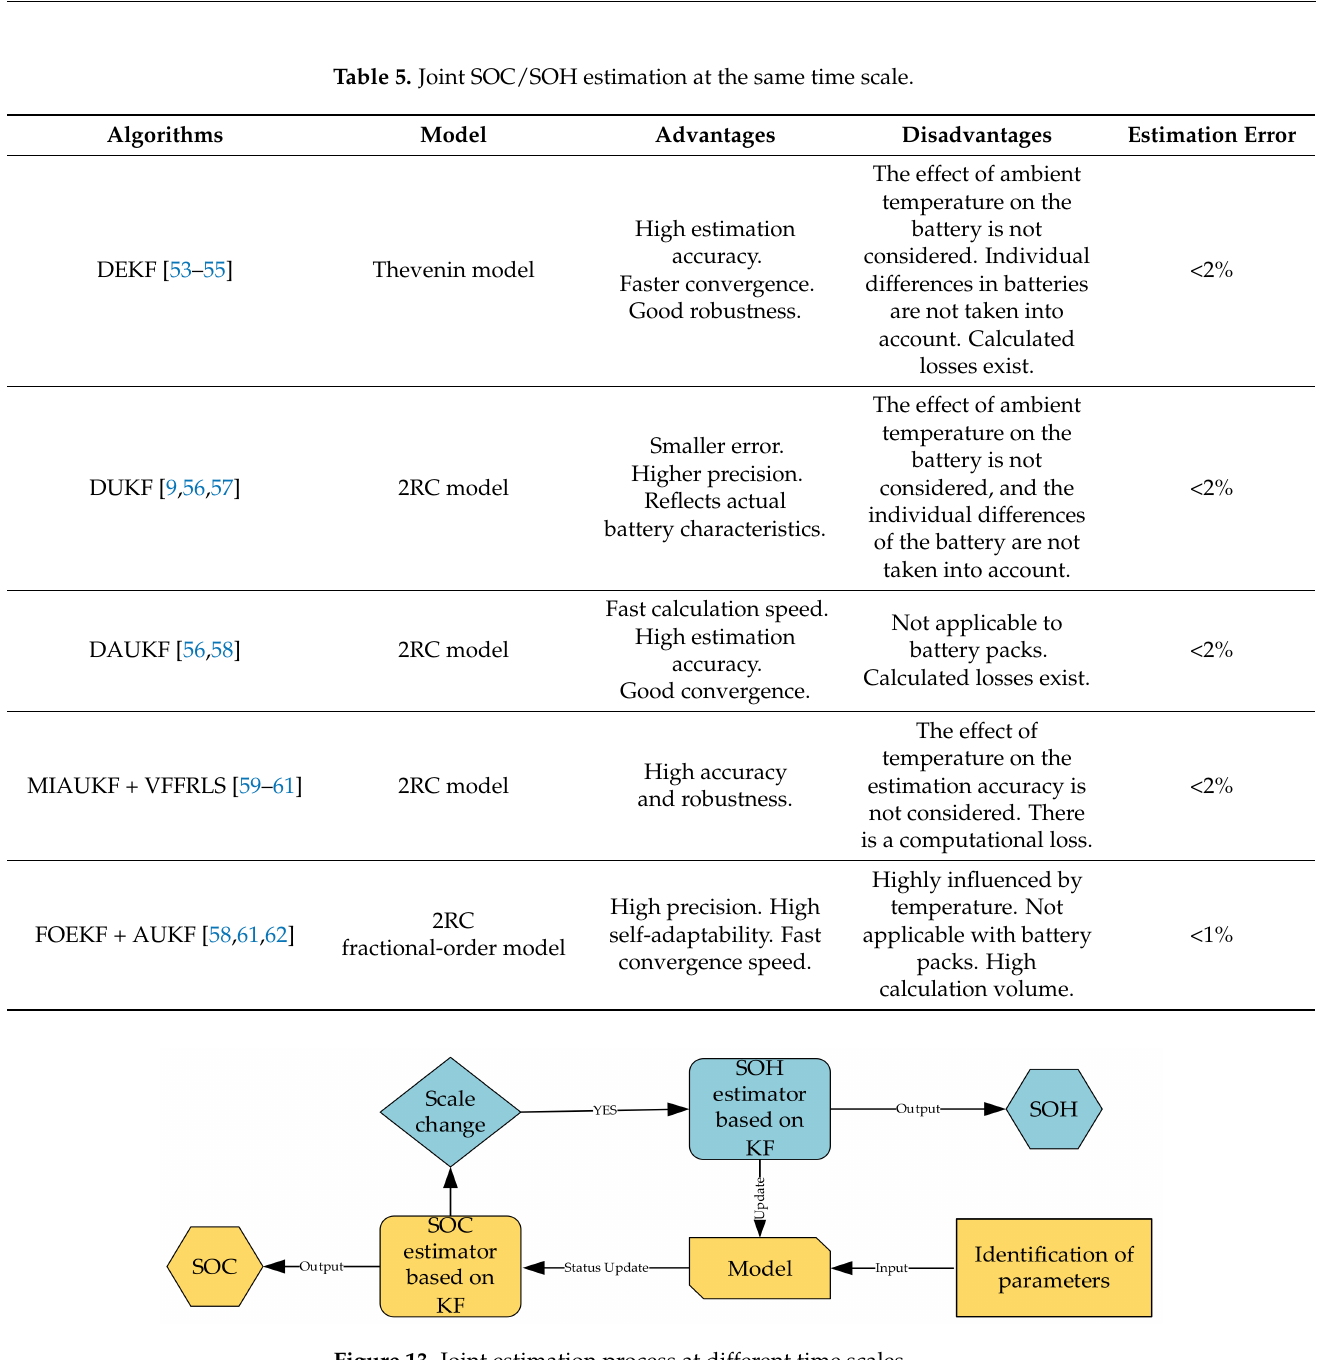
Figure 13. Joint estimation process at different time